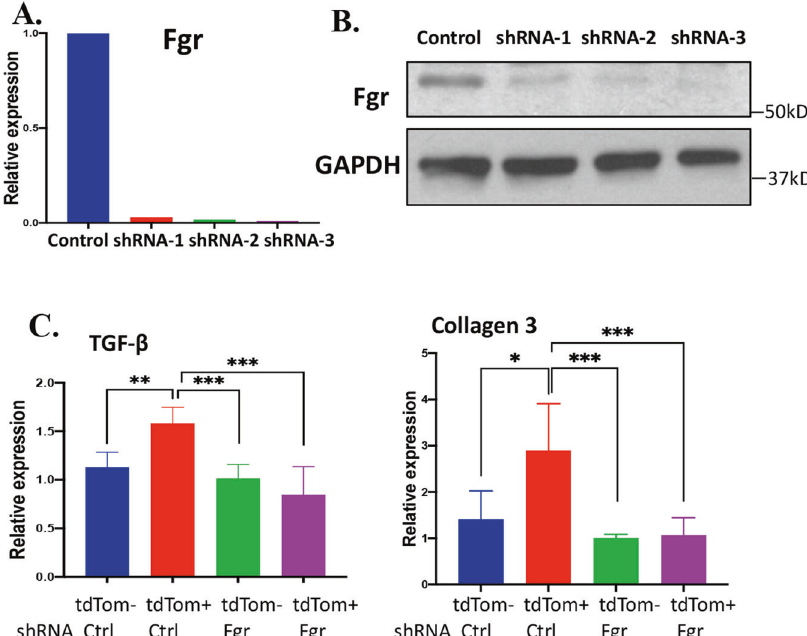
Fig. 6 shRNA inhibition of Fgr in senescent (tdTOM + ) cells abrogates the induction of pro fi brotic genes. A Validation of the ef fi cacy of 3 shRNAs by RT-qPCR targeting the coding region of Fgr after 72 h of transient transfection in mouse bone marrow stromal cells. B Validation of the ef fi cacy of three shRNAs by western blotting after 72 h of by transient transfection in mouse bone marrow stromal cells. C Stable control or Fgr shRNA knockdown tdTOMp16 + cells were irradiated and sorted non-senescent (tdTOM − ) and senescent (tdTOM + ) cells were cultured on top well of the transwell, and the target C57BL/6 stromal cells were cultured on the bottom well and after 10 days, target C57BL/6 cells were harvested for RNA and RT-qPCR was performed for TGF- β and Collagen 3 genes. ( n = 3, * P = <0.05; ** P = 0.01, NS non-signi fi cant), P values were calculated by t